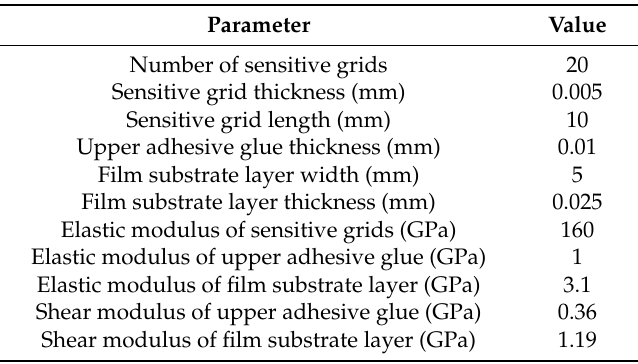
Table 1. Properties of materials used in the resistance strain-type transducer